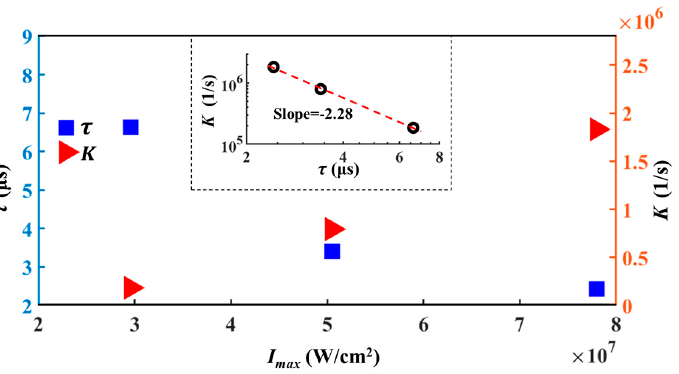
Figure 4. Comparisons among photochemical reaction coefficient K , photobleaching time constant τ and laser power density I max . The inset displays the relationship of K and τ in a log–log